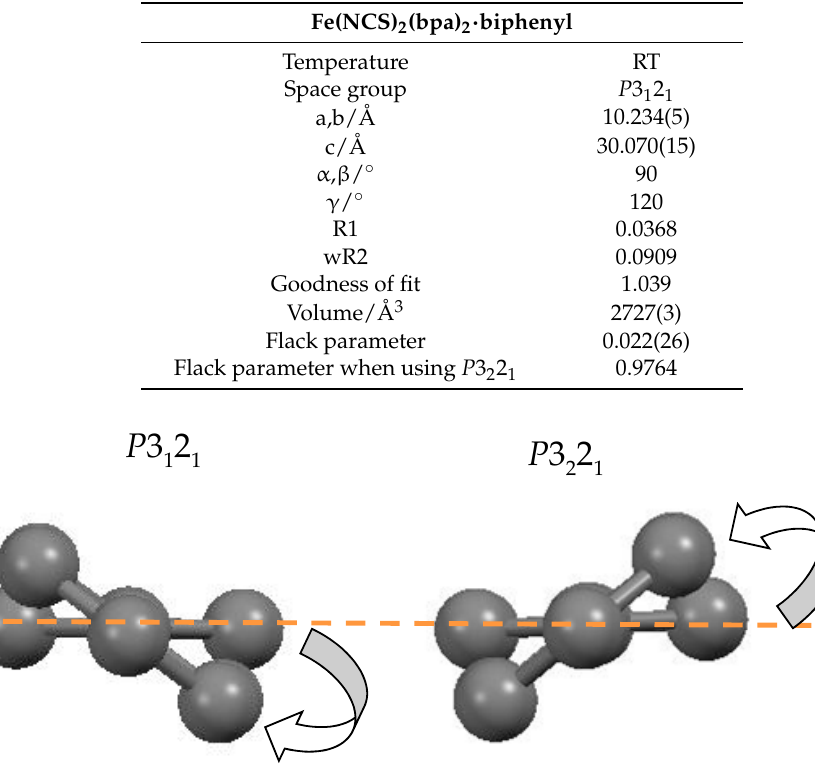
Figure 4. Space-filling view of [[Fe(NCS) 2 (bpa) 2 ]·biphenyl] n . Upper and lower 1D chain sheets and guest biphenyl are shown in ( a ) and middle 1D chain is shown in ( b ).